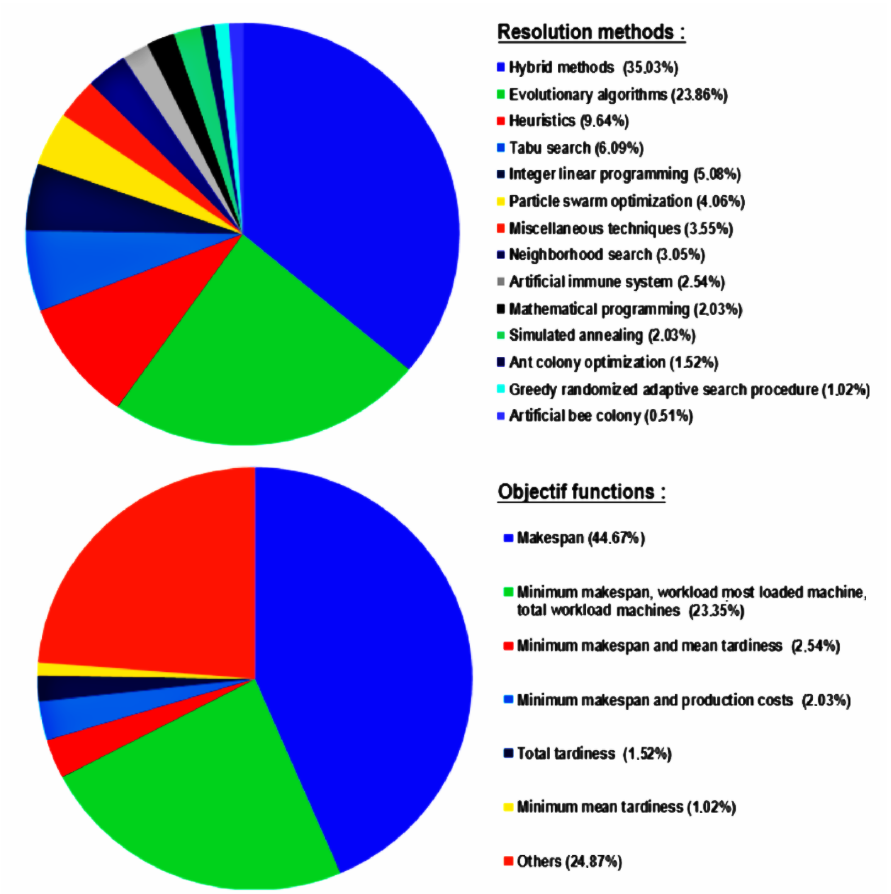
Figure 1. Bibliographical summary of the resolution methods used for flexible job shop problems and the objective functions studied in the literature: 191 papers between 1990 and 2014 (Chaudhry and Khan